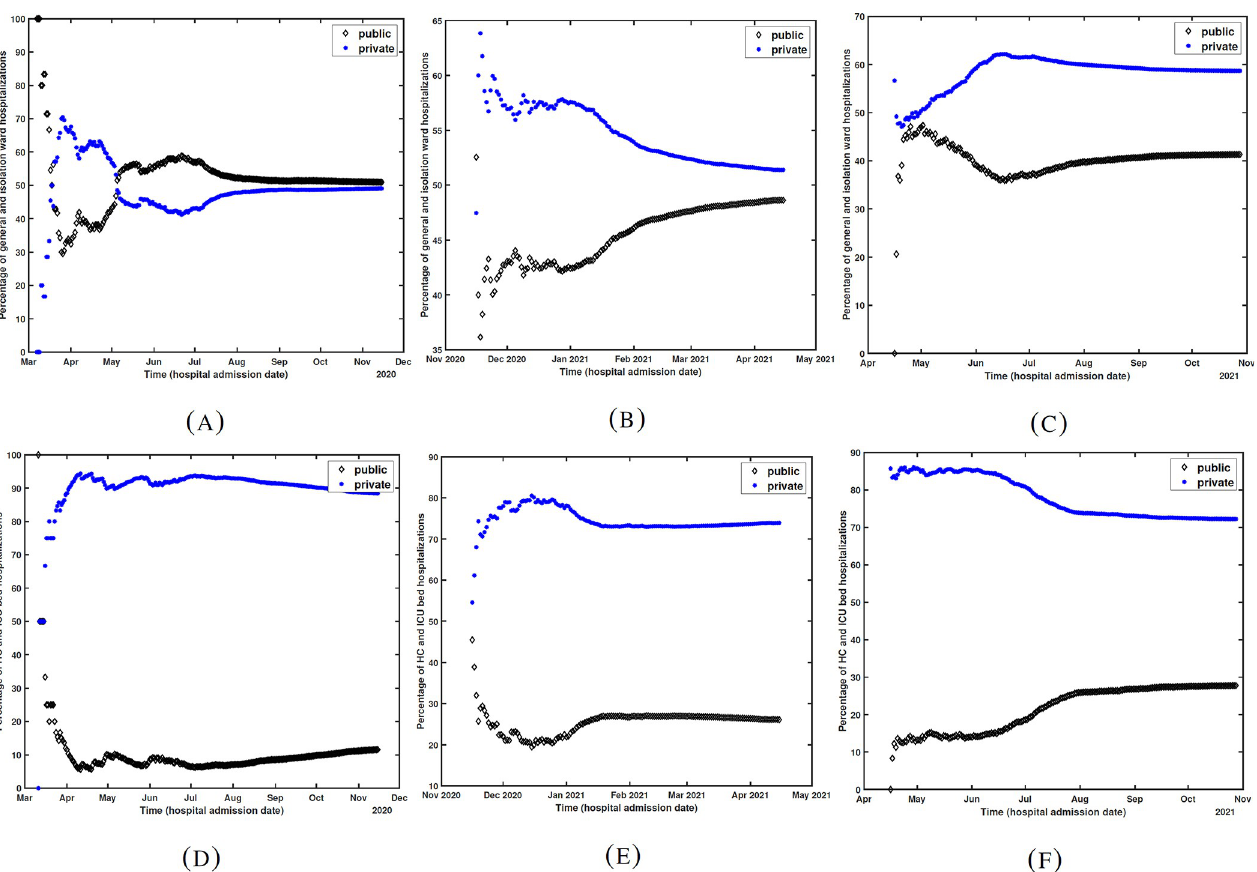
Fig 6. (A-C) Percentage of general/isolation ward hospitalizations in public and private sectors over time during the three waves, respectively (D-F) Percentage of HC/ICU hospitalizations in public and private sectors over time during the three waves, respectively (100 × cumulative number of ward (ICU) hospitalizations in public (private)/cumulative number of ward (ICU) hospitalizations in both